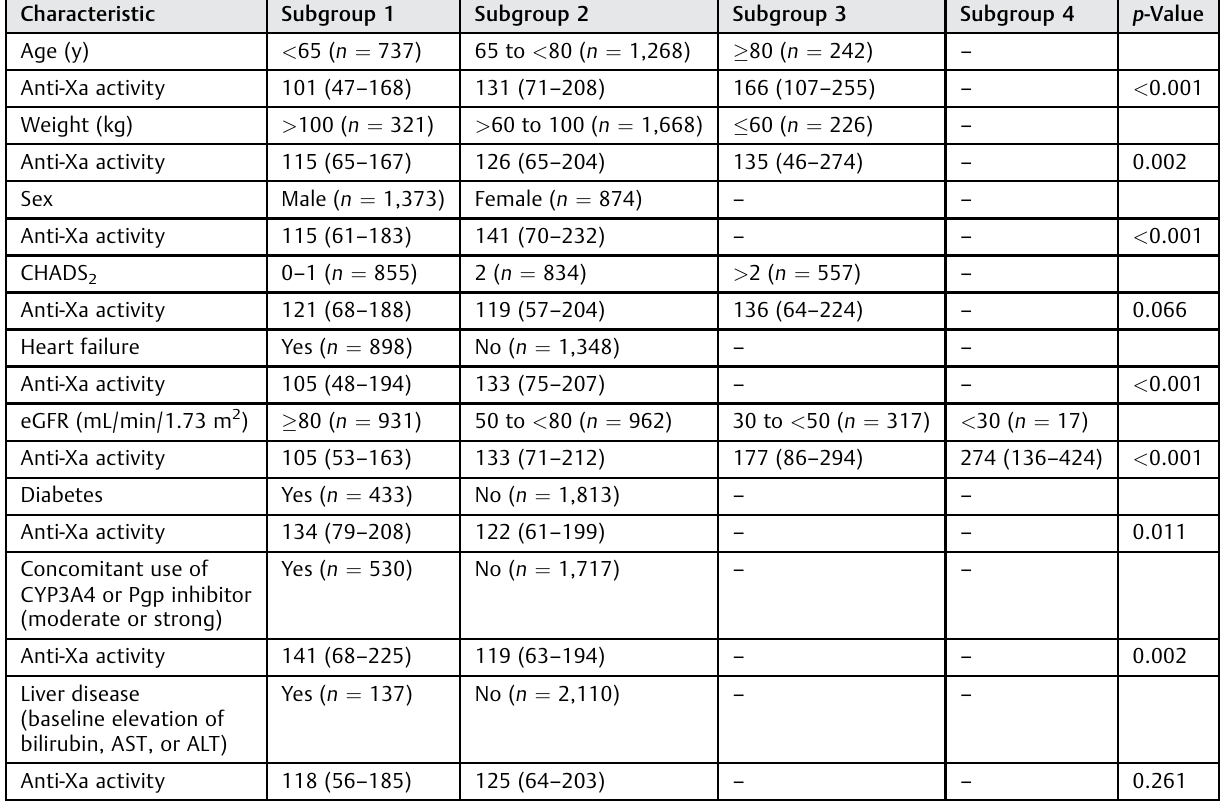
Table 3 Effect of clinical characteristics on apixaban anti-Xa activity